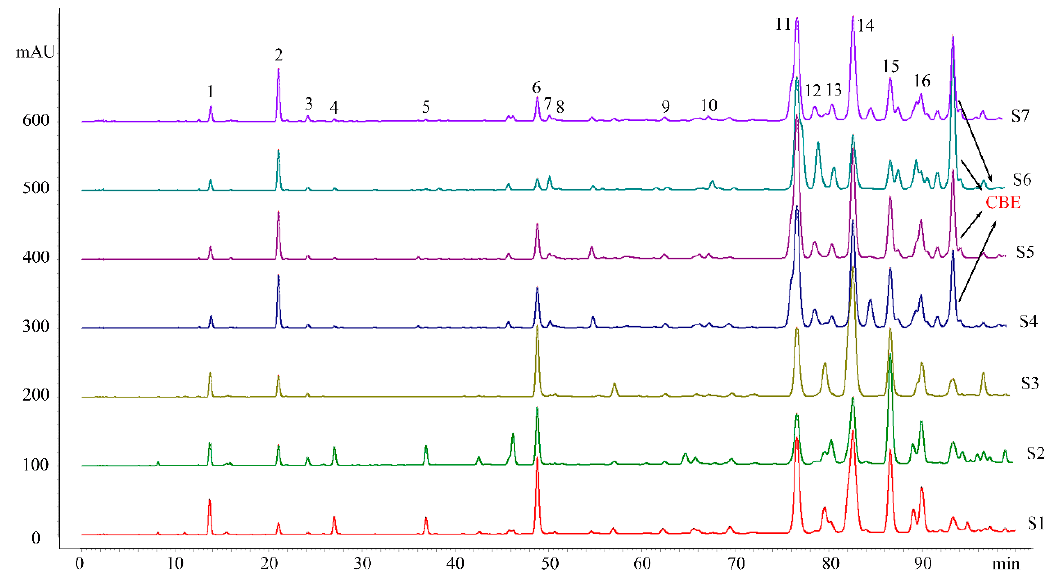
Figure 3. The HPLC chromatograms of common Chinese propolis (S1–S3) and the CMB propolis Figure 3 . The HPLC chromatograms of common Chinese propolis (S1-S3) and the CMB propolis (S4- S7).